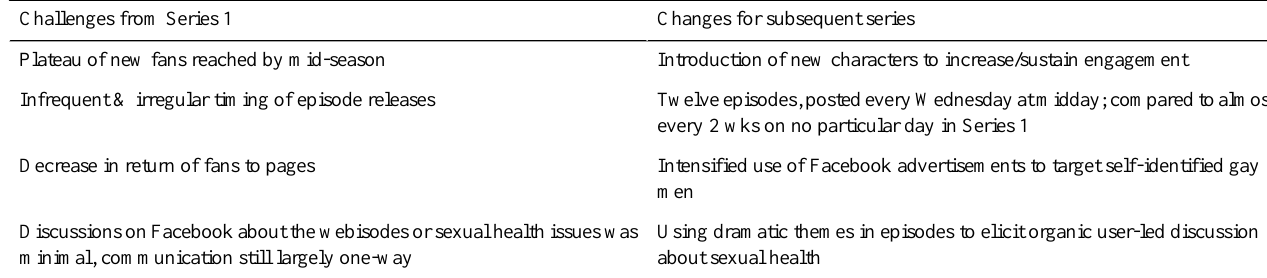
Table 3. Changes made to QAF project implementation following evaluation of Series 1 pilot.